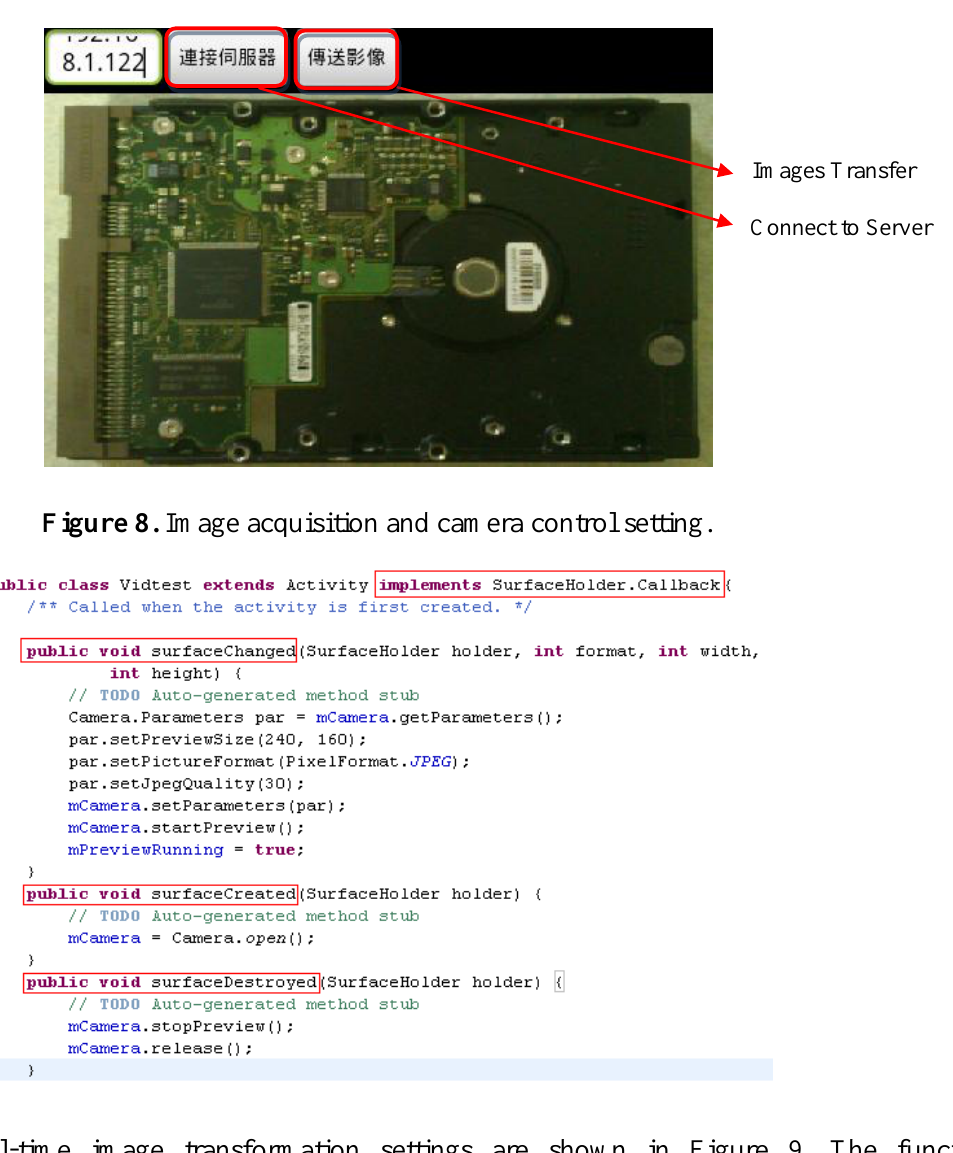
Figure 7. The real-time image capture interface.